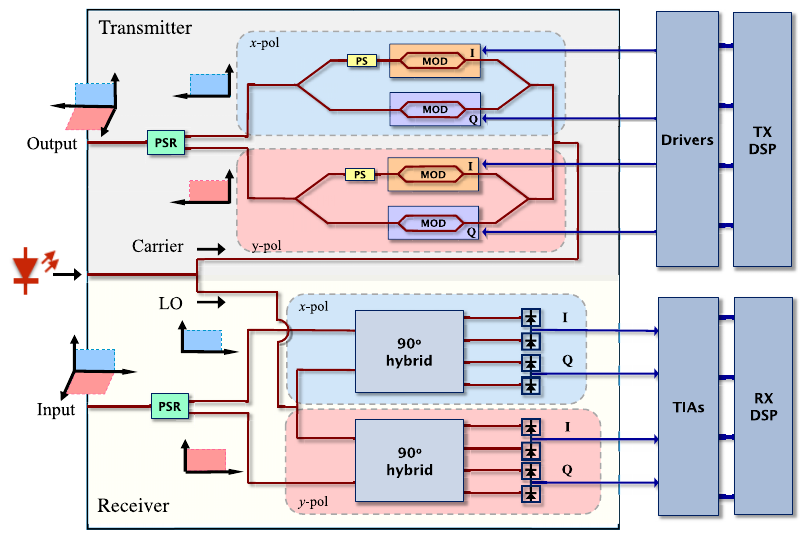
Figure 6: Block diagram of a fully integrated photonic coherent transceiver.